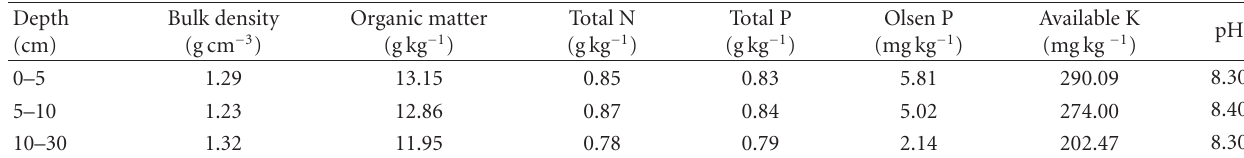
Table 1: Soil chemical and physical properties at the start of experiment.